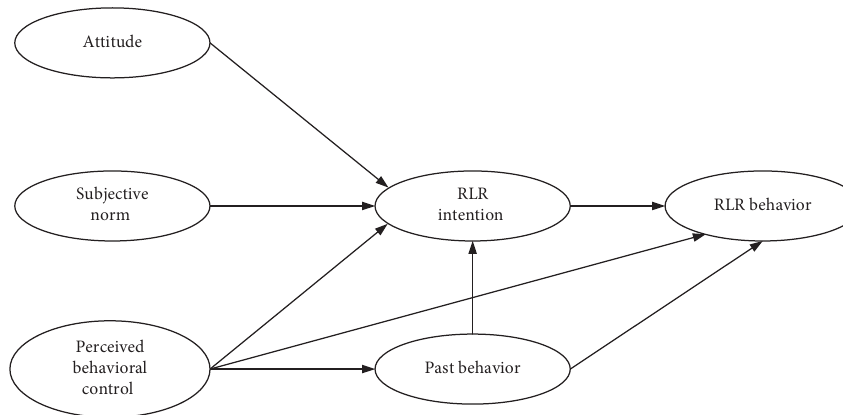
Figure 1: An extension of the TPB